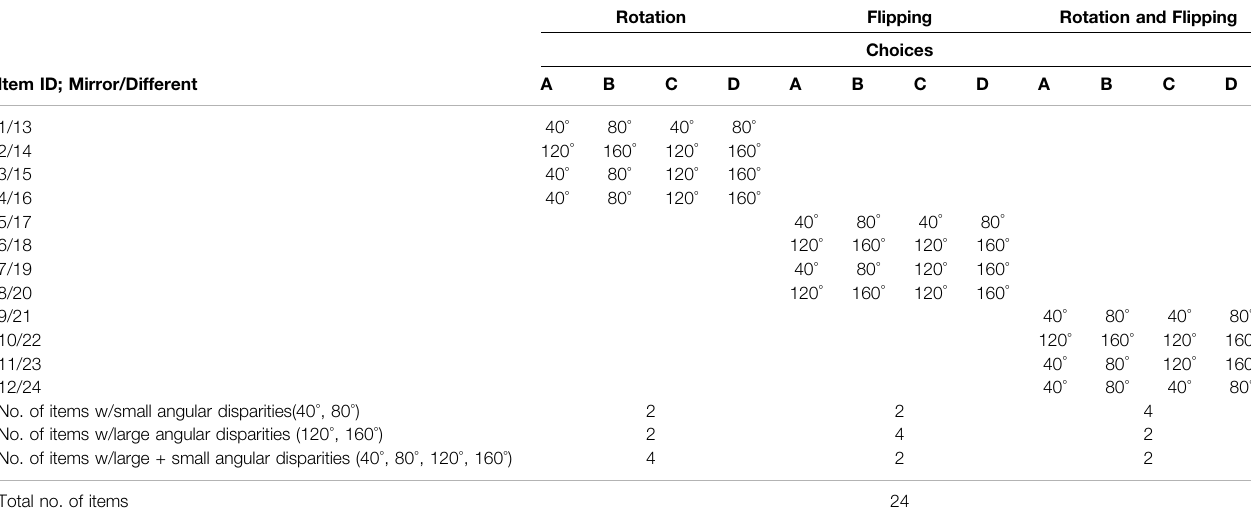
Rotation Flipping Rotation and Flipping